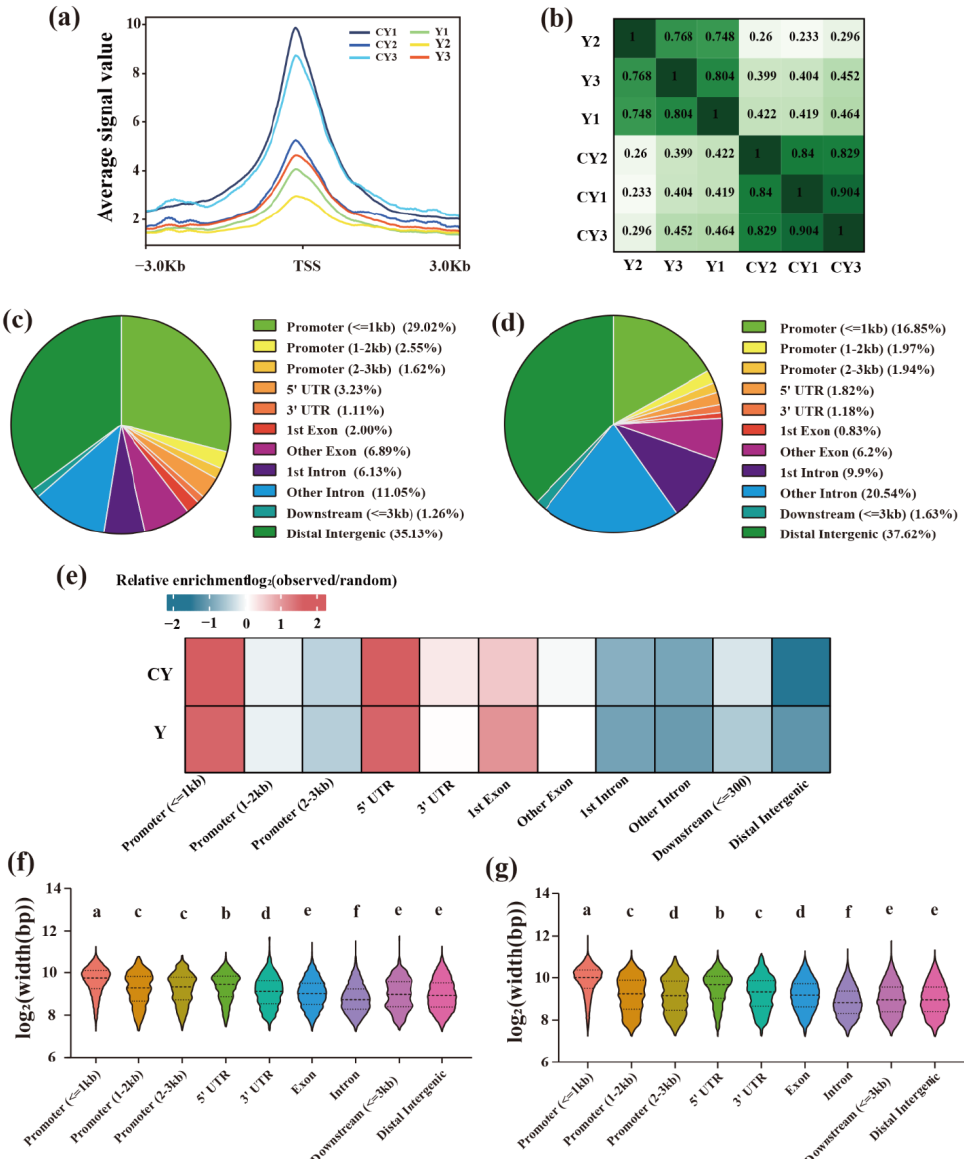
Figure 1. Open characteristics of the chromatin found in the testes of yaks and cattle-yak. ( a ) Distribution trend diagram of ATAC-seq signal near TSS, ( b ) Map showing the correlation analysis, ( c ) Yak and ( d ) cattle-yak peaks distribution diagram on the genomic functional elements, ( e ) Peaks relative enrichment diagram on the genomic functional elements, ( f ) Yak and ( g ) cattle-yak peaks width distribution violin diagram. CY: cattle-yak, Y: yak. The same letter in the violin figure indi- cates that the difference between the groups is not significant, and different letters indicate that the difference between the groups is significant ( p <